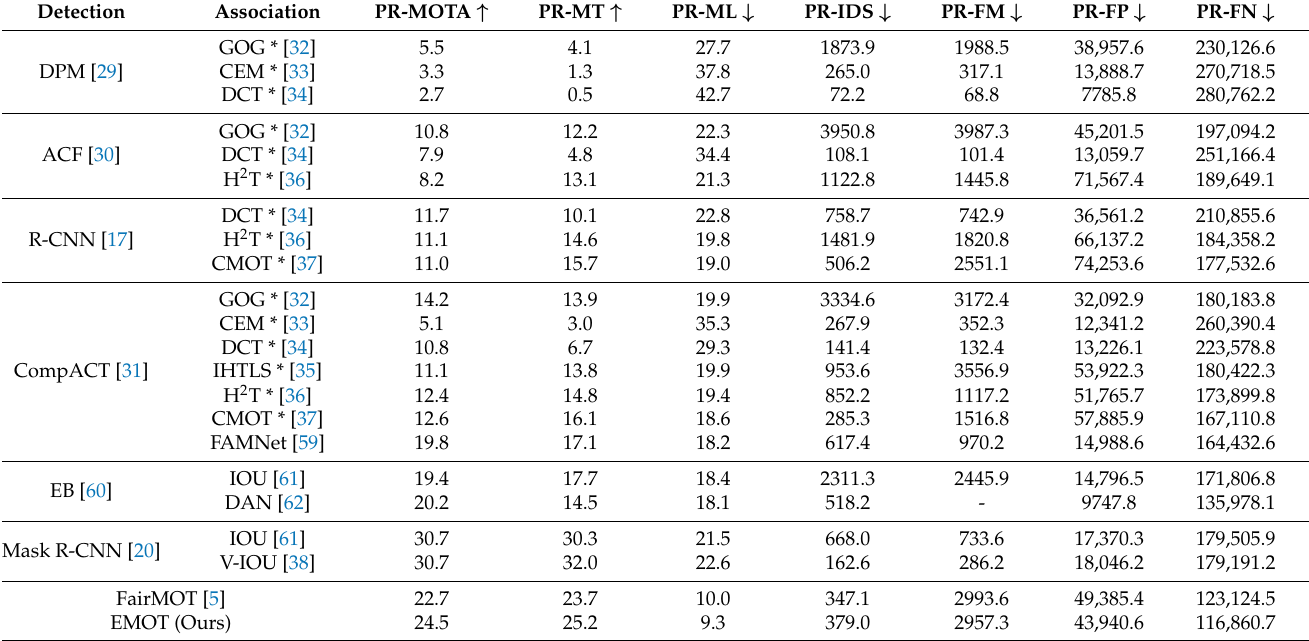
Table 5. MOT results of our single-shot MOT system and different trackers, which are evaluated on the UA-DETRAC-test set. The results of * were taken from Wen et al. [11] and the rest of the results were taken from their own papers, except for FairMOT.